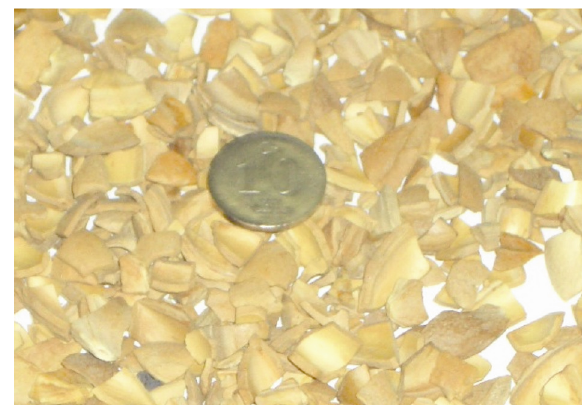
Fig. 1. Apricot pip shells